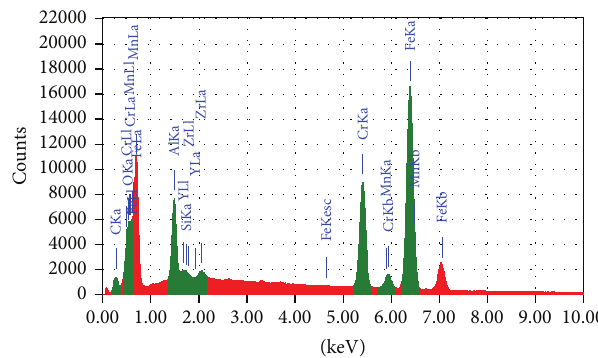
Figure 1: EDX analysis of the as-received